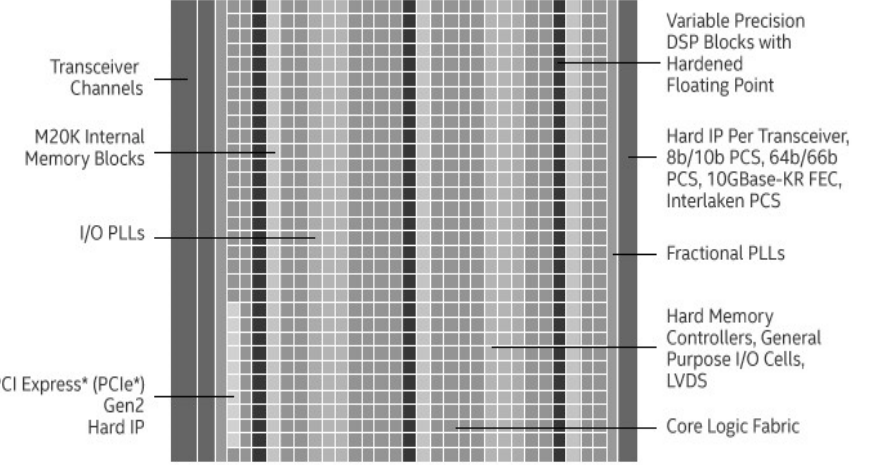
Figure 4. Intel Cyclone 10 GX FPGA architecture © [15].